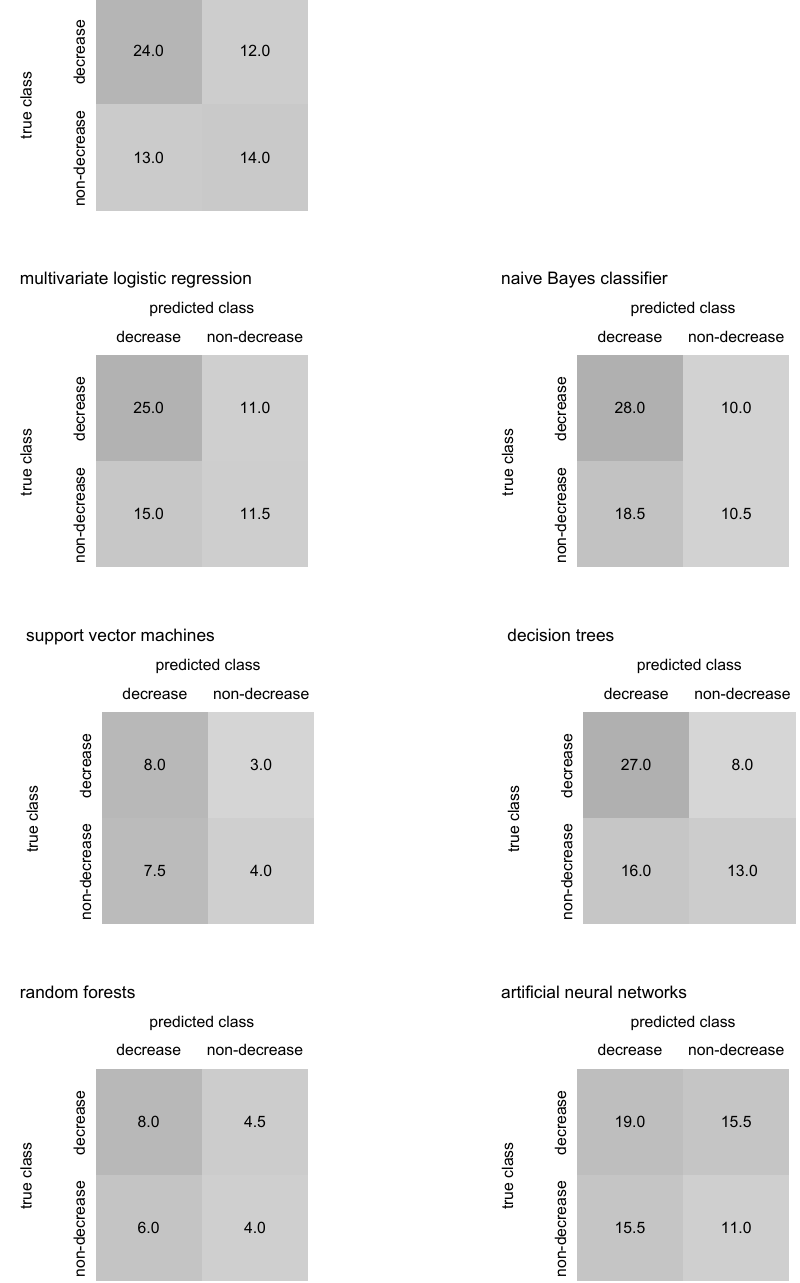
Figure 11. Median confusion matrices for predicting COVID-19 IgM antibody blood level decrease or non-decrease below laboratory cut-off using the listed